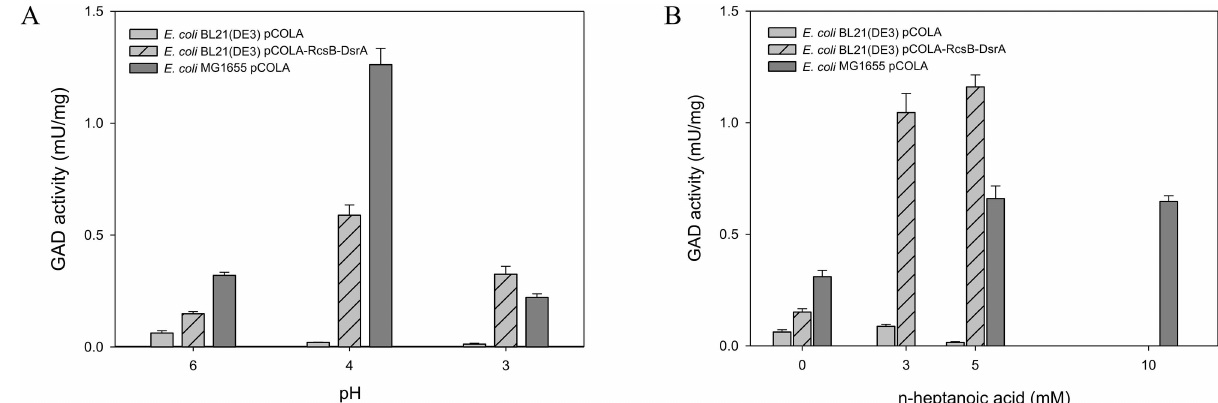
Fig 4. The relationship between GadA/B activity and cultivation pH (A) or n-heptanoic acid concentration (B). The GadA/B activities of the recombinant E . coli BL21(DE3) pCOLA (empty vector) ( grey bar ), E . coli BL21(DE3) pCOLA-RcsB-DsrA ( grey bar with diagonalline ) and E . coli K-12 MG1655 pCOLA ( dark grey bar ) were determinedwhen cells were cultivated at different pH and at different n-heptanoic acid concentration. Values are the mean of more than three independent samples. Bars represent standard error of the